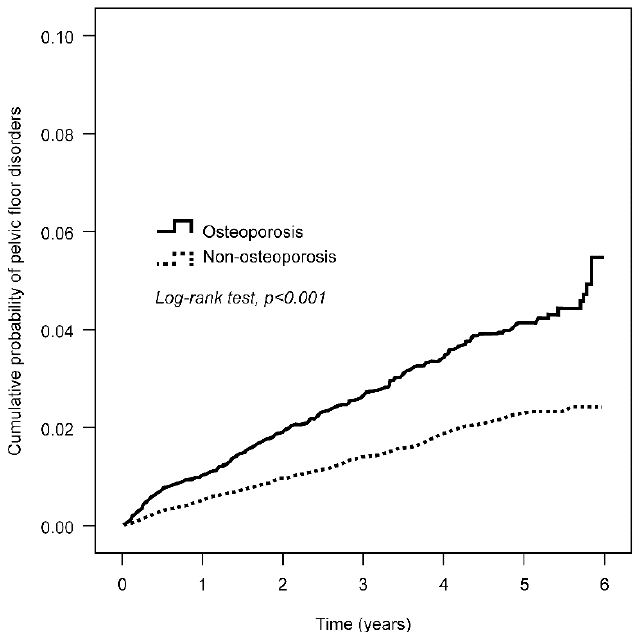
Figure 2. Kaplan–Meier analysis of the cumulative probability of pelvic floor disorders at the 6-year follow-up. At the 6-year follow-up, the cumulative incidence for developing urinary incontinence in the OS group (black line) is higher than in the Non-OS group (dotted line). The p -value is less than 0.001 after the log-rank test.